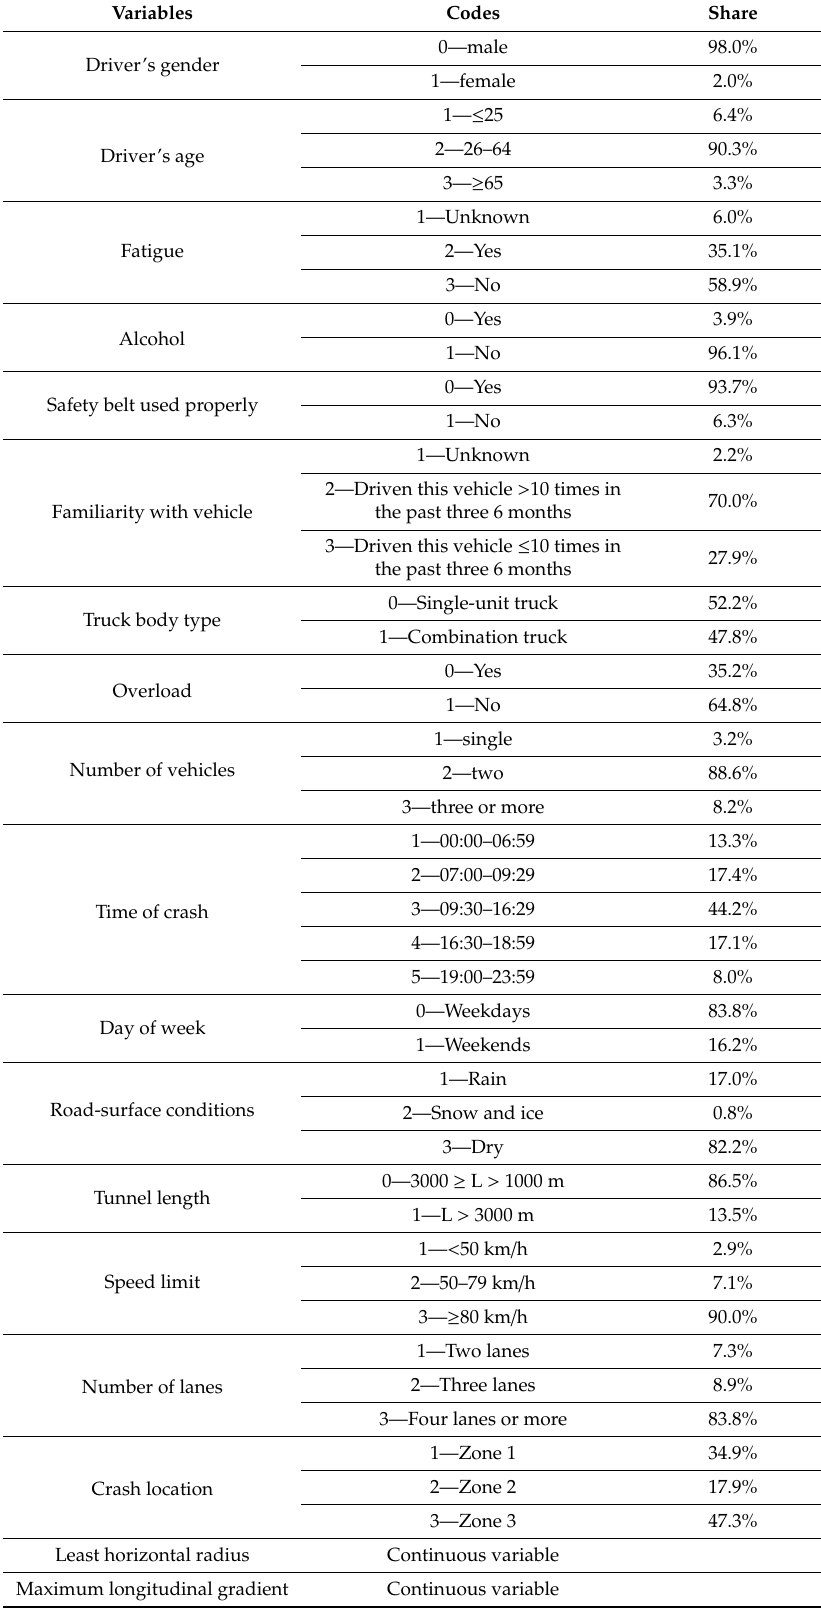
Table 2. Descriptive Statistics of